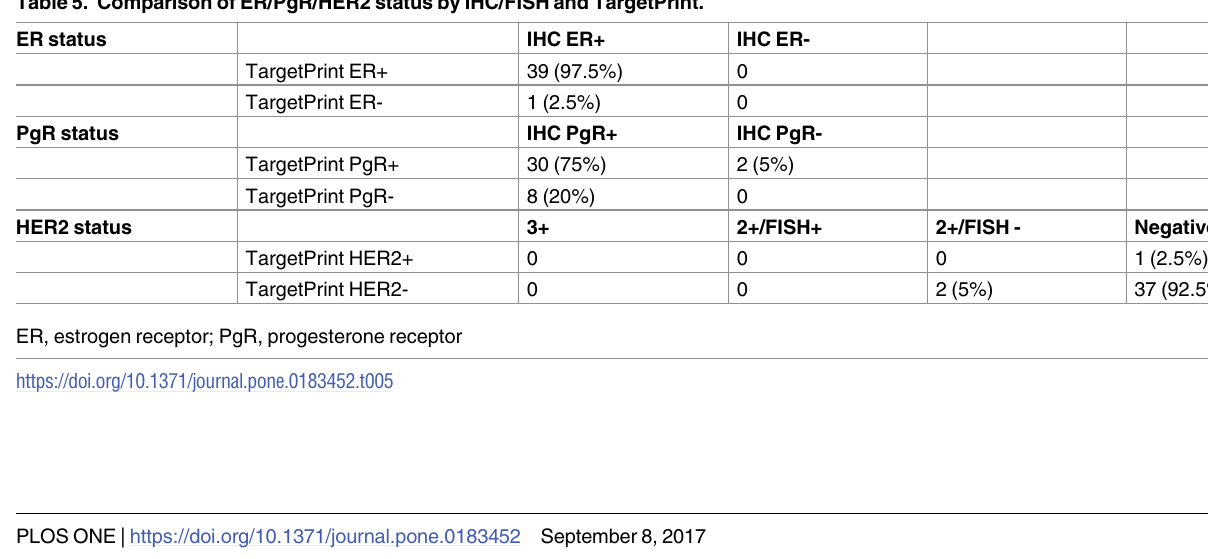
readout (Table 5): of the 40 ER-positive cases by IHC, 39 (97.5%) were TargetPrint ER+. The